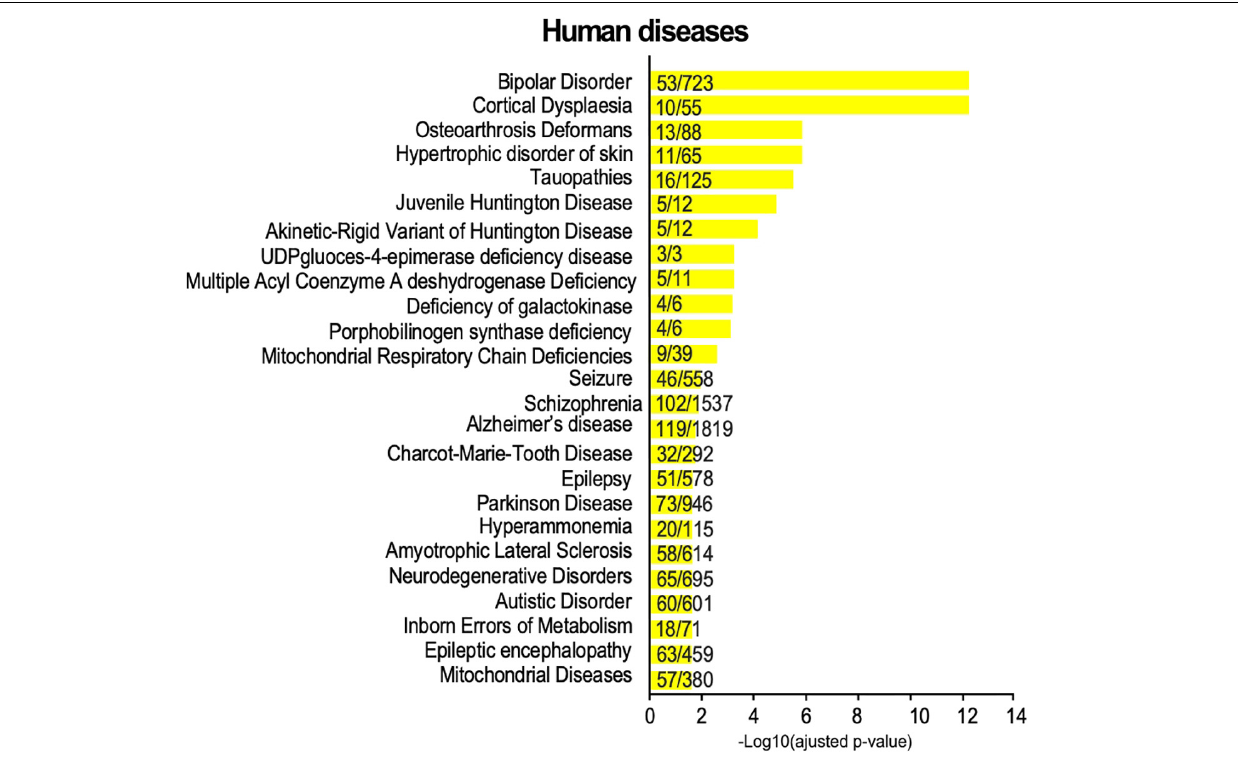
FIGURE 6 | Disease annotation enrichment analysis of the synaptic SUMO2/3-ylome. Proteins from the SUMO2/3 dataset were analyzed for correlation with human diseases using ToppGene with the full gene set as background. Categories were classified according to the -Log10 of the adjusted p -value using the Benjamini-Hochberg method. The number of counts compared to the total number of hits in the category is indicated. Details are available in Supplementary Table 6